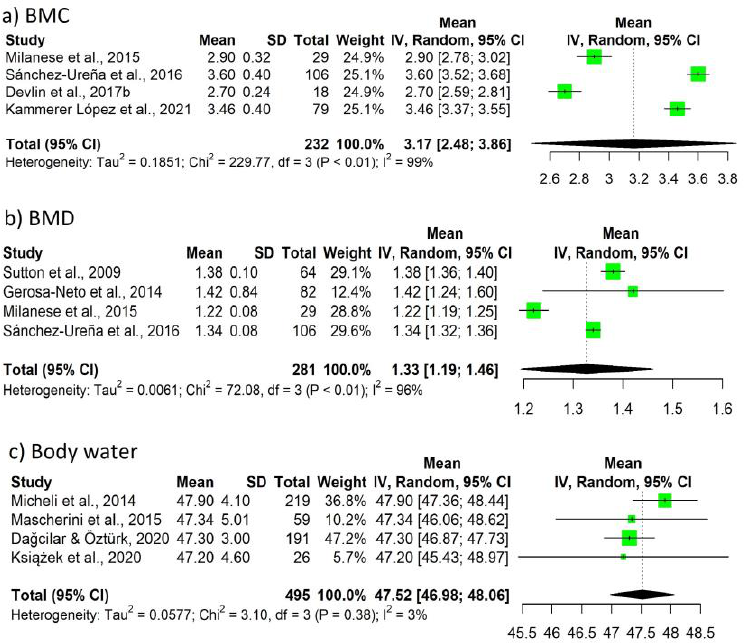
Figure 5. Forest plot ( a ) BMC, ( b ) BMD, and ( c ) body water.